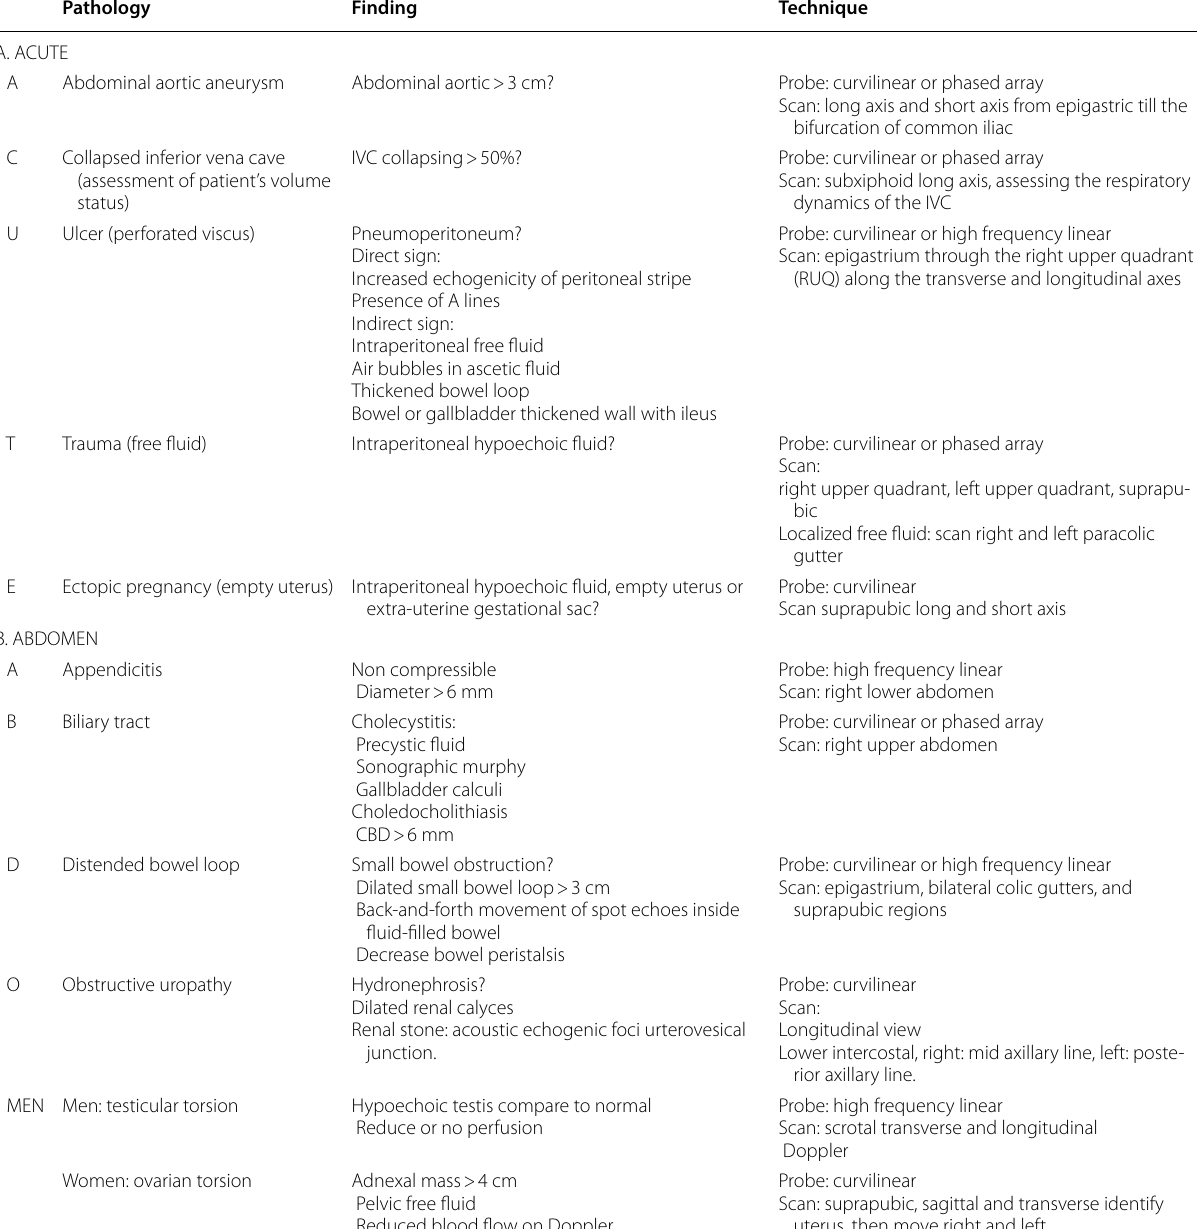
Table 1 ACUTE ABDOMEN sonographic aproach: findings and techniques Pathology Finding